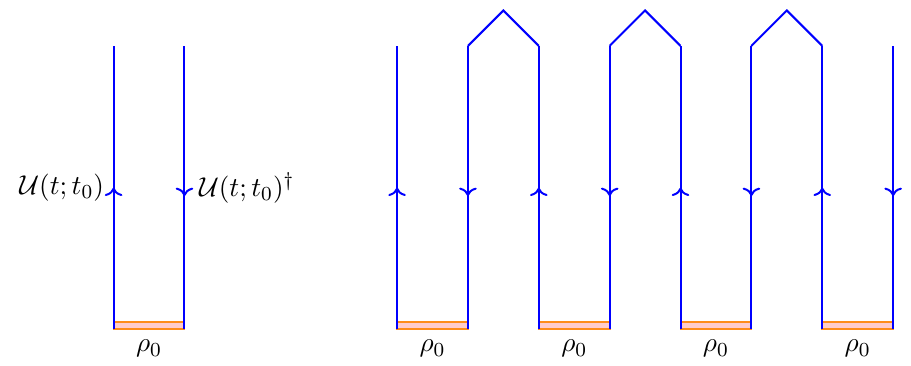
Figure 1. A schematic illustration of the real-time (Schwinger-Keldysh) contours for the com- putation of the density matrix ρ ( t ) (left) and its powers (right). The past boundary condition is supplied by the prescribed initial state ρ and the direction of time evolution is explicitly indicated 0 by the arrows. Forward evolution corresponds to the ket part of the state while backward evolution corresponds to the bra part. The reduced density matrix ρ ( t ) associated with some spatial domain A at t = 0 is obtained by sewing together the U ( t ; t ) and U ( t ; t ) † parts of the left panel along the 0 0 complementary t = 0 domain A c , while leaving open the parts along A . It’s powers thus involve similar contractions between the two parts of any given copy, while the A parts are again contracted with neighboring copies as shown at